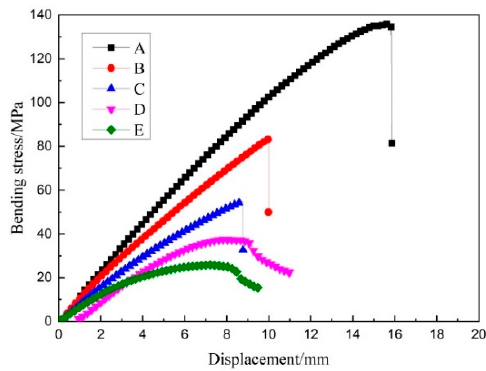
Figure 9. Warp stress–displacement curve.